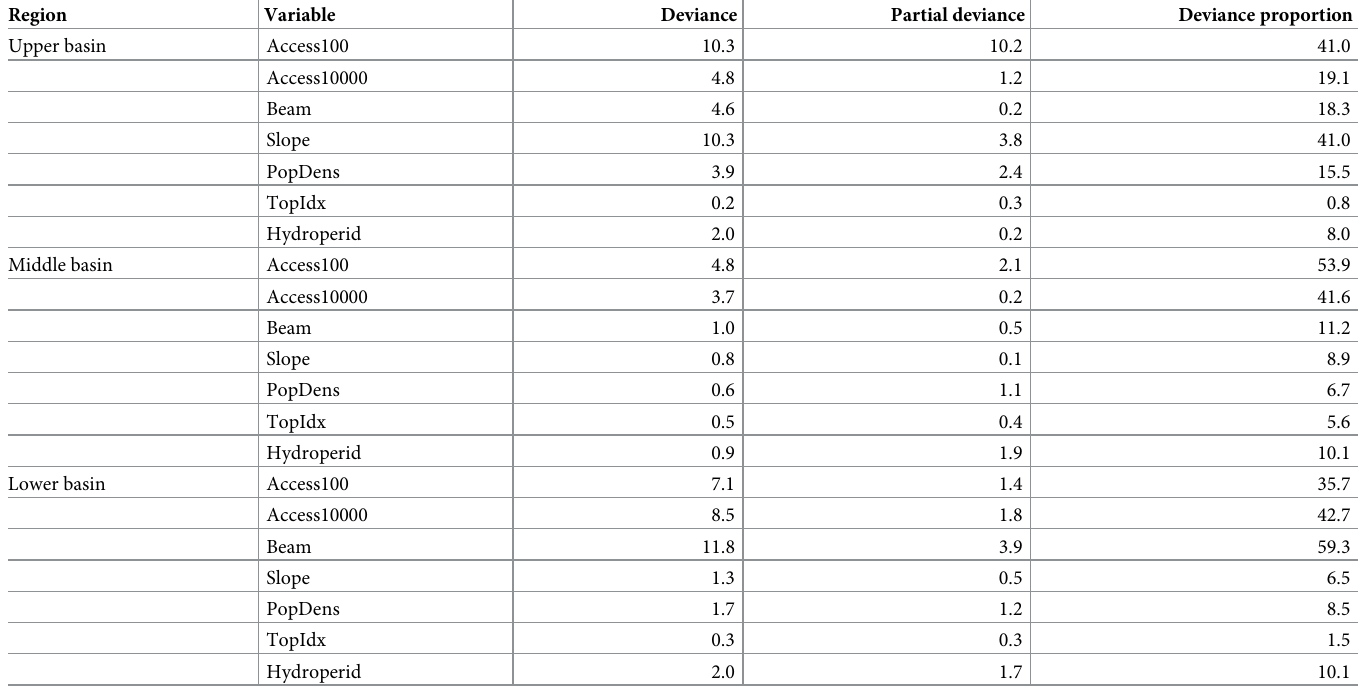
Table 2. Results from generalised additive models. Percentage of the deviance explained by models built using single variables separately and partial deviances in the presence of all competing variables. The last column shows the deviance explained by each univariate model expressed as a percentage of the total deviance explained by the most complex multivariate model.